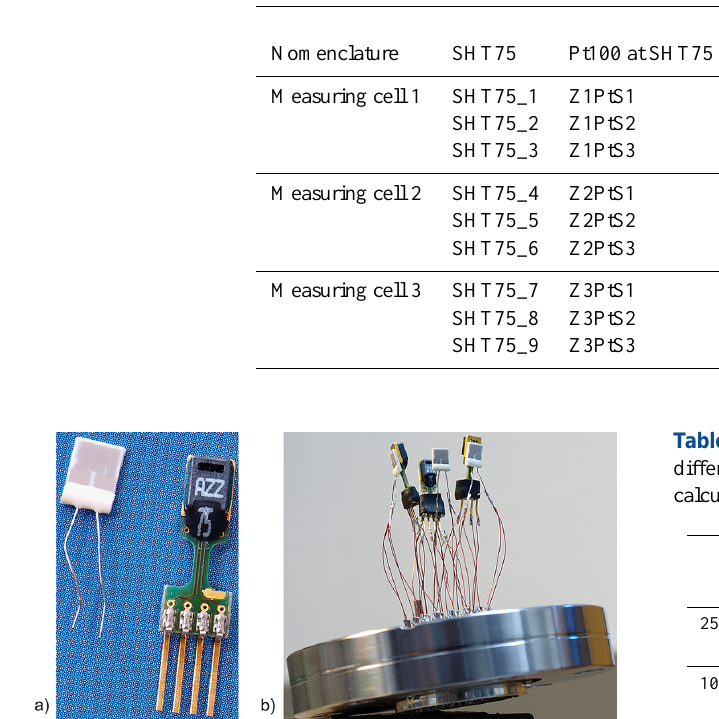
Figure 3. (a) Left: Pt100 (6W 538), and right: SHT75; (b) three SHT75/Pt100 combinations with the fourth Pt100 placed in the cen- ter.